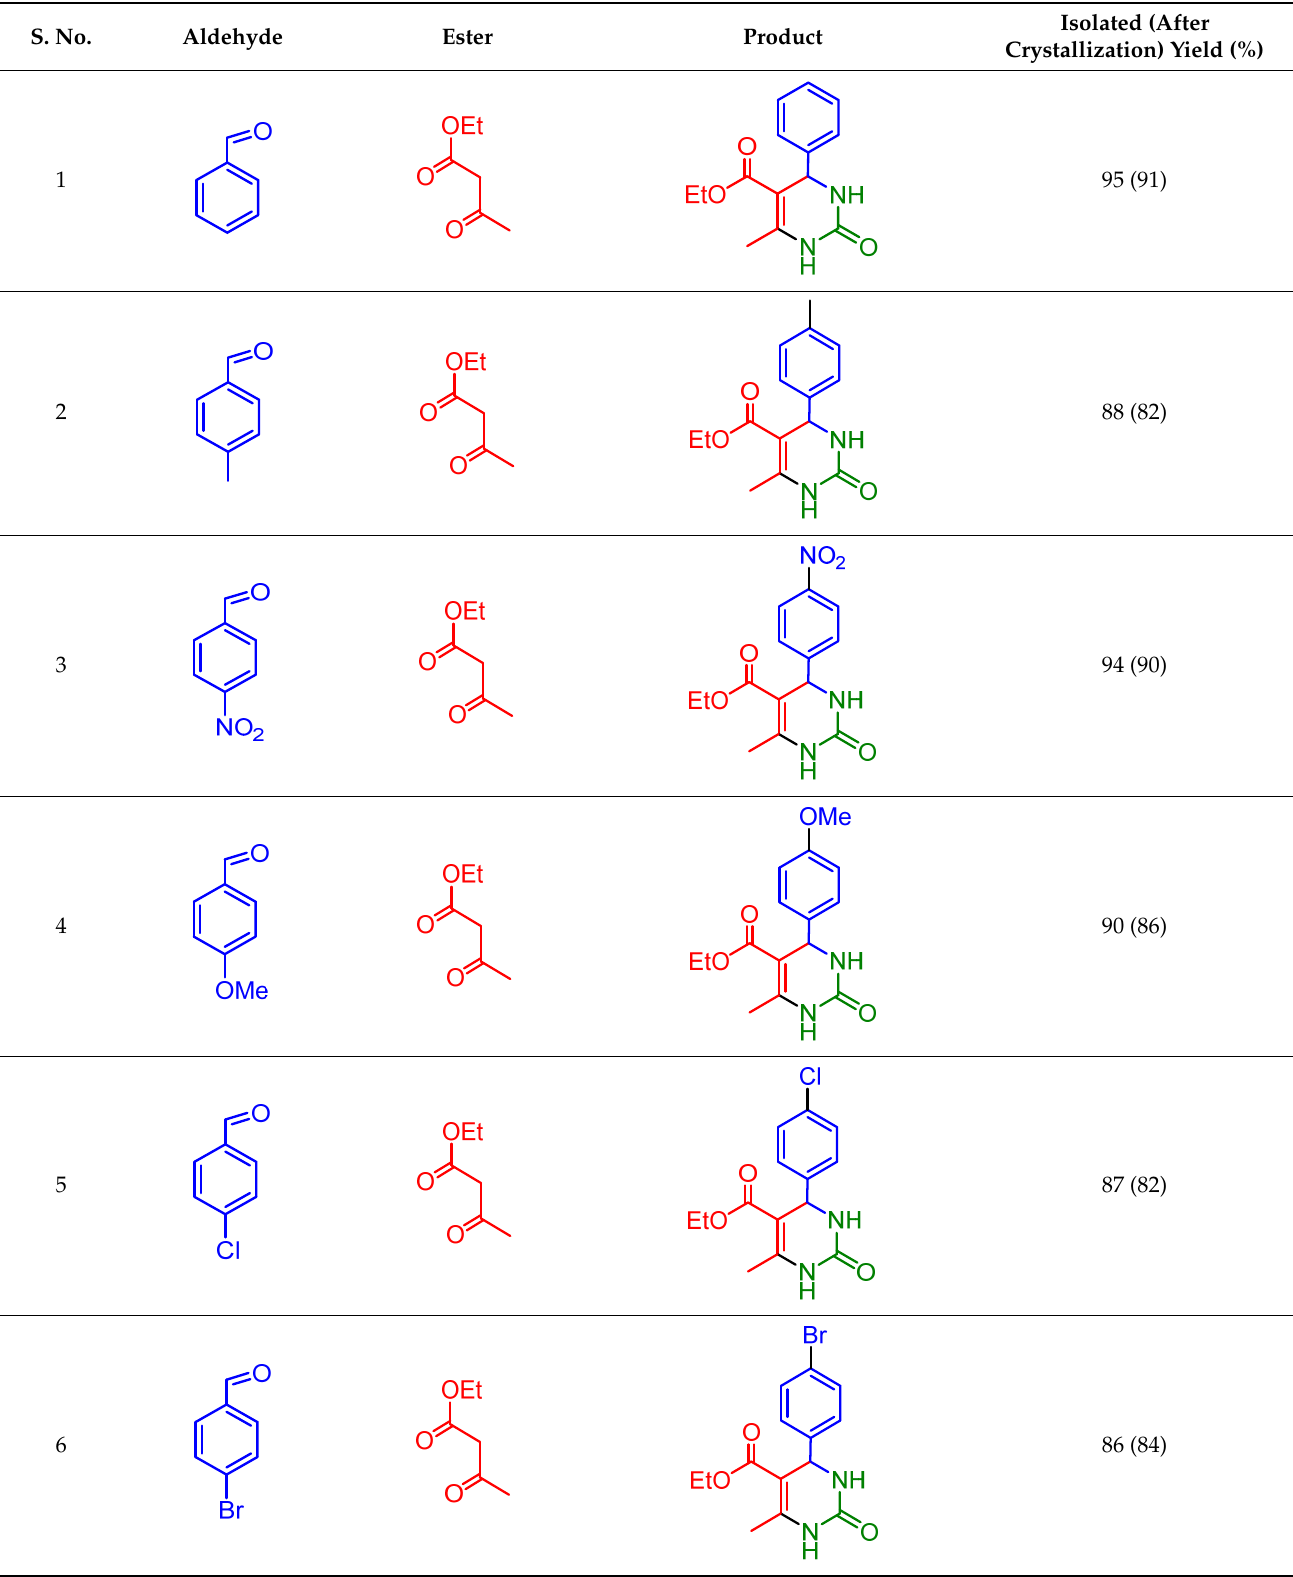
Table 3. Details for multicomponent Biginelli reaction for the synthesis of DHPM (reaction conditions: respective aldehyde (5 mmol), respective ester (5 mmol), urea (6 mmol), catalyst 2 (0.015 g), and aqueous 30% H 2 O 2 (2.26, 20 mmol)) under solvent-free conditions at 80 °C for 3 h of reaction time.